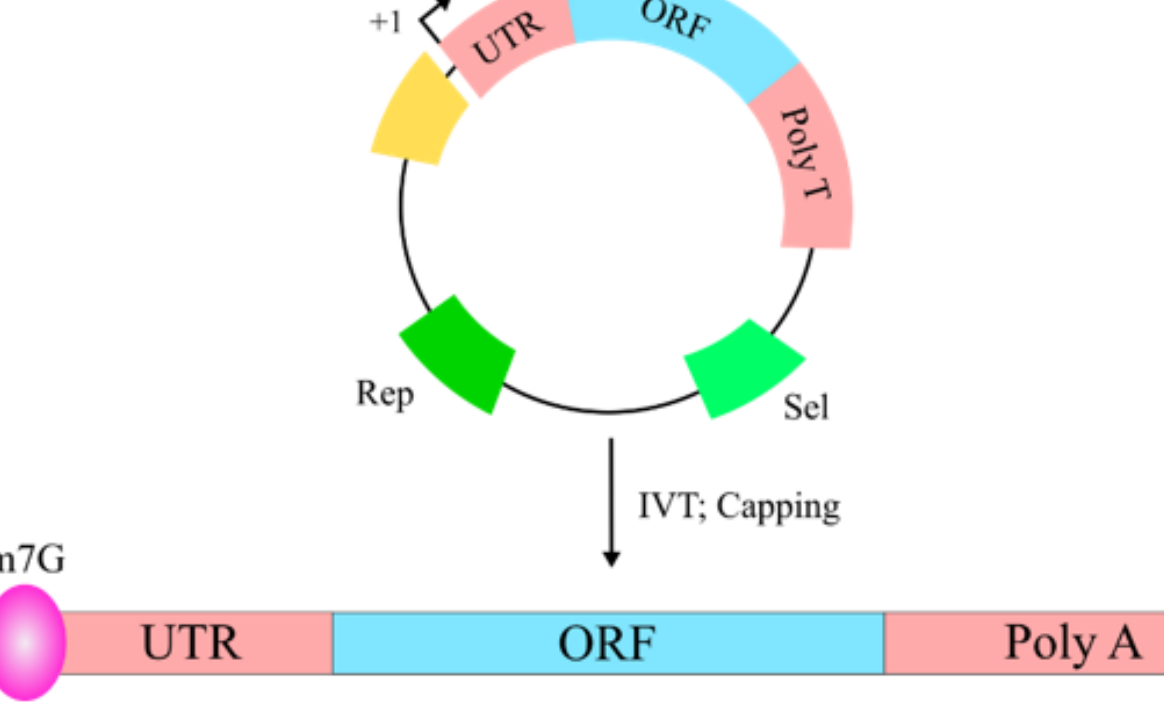
Figure 6. Representation of a vector to produce mRNA-based vaccines. The vector contains the basic elements to produce a functional mRNA to be used in vaccination. This vector contains a strong viral RNA polymerase promoter (yellow), an initiation site (+1), an untranslated 3′ sequence (UTR, enhances translation), the ORF which encodes the antigen, a poly T tail (produce a poly A to enhance translation), a selection marker (Sel) and an origin of replication (Rep). After IVT, the mRNA is capped to produce a m7G mRNA, which can be purified and used for vaccination.